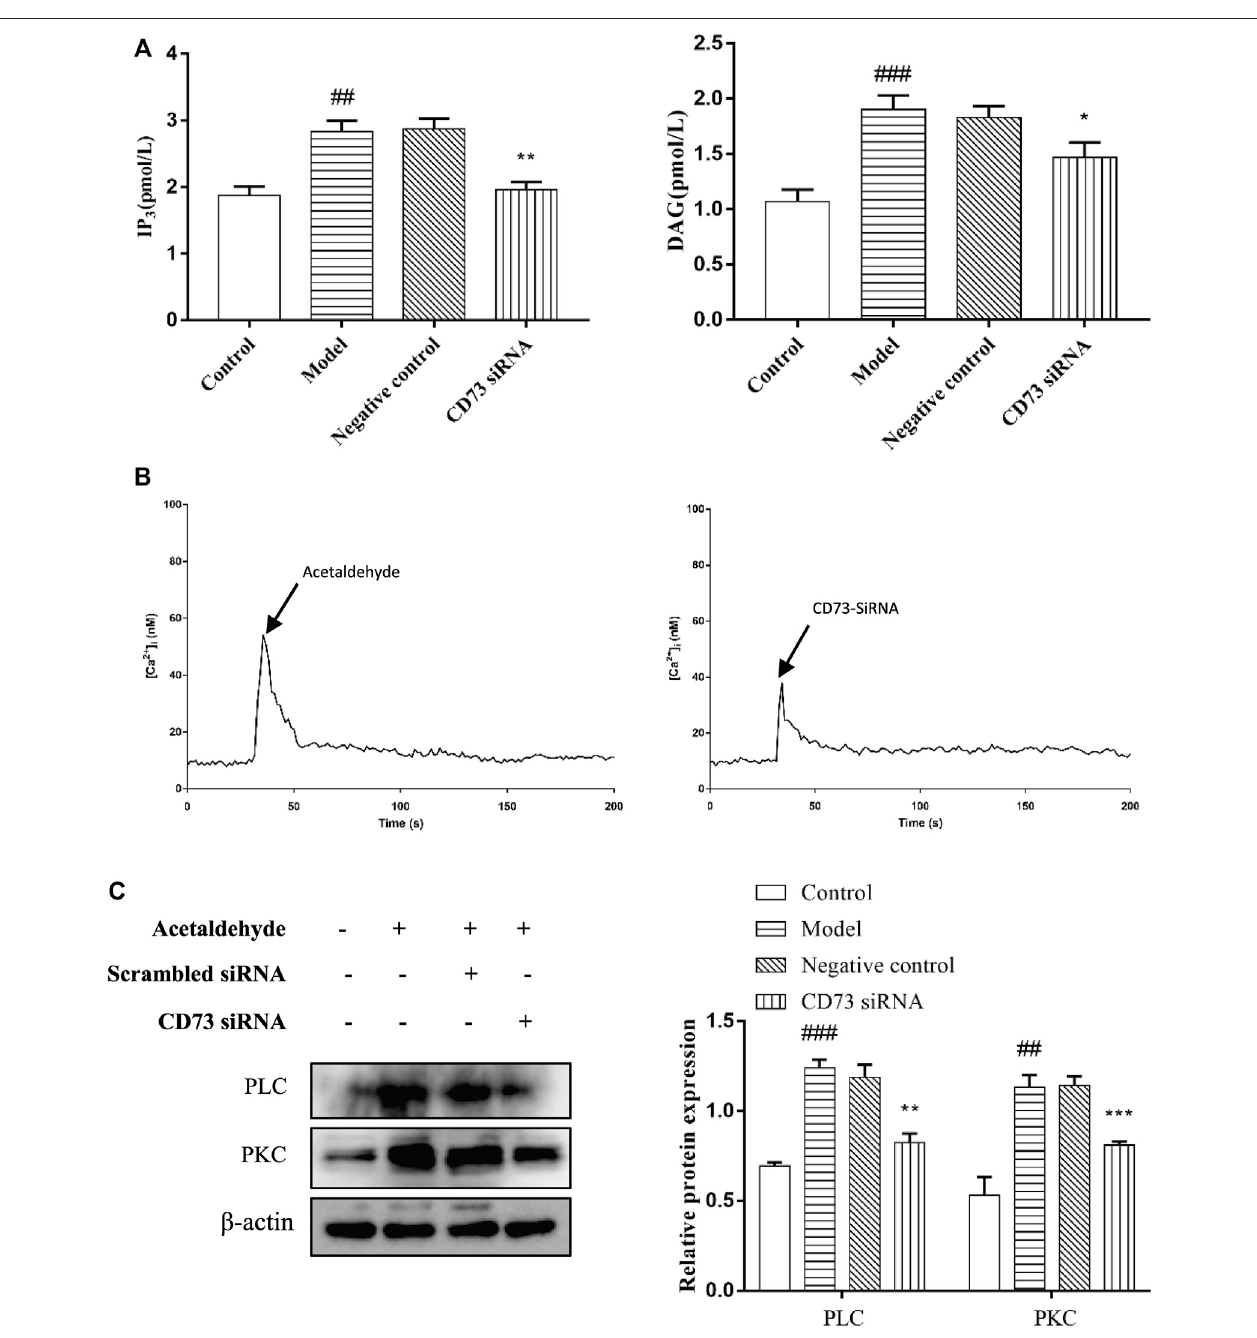
FIGURE 8 | CD73 positively regulates PLC- IP 3 -Ca 2+ /DAG-PKC signaling pathway activity in acetaldehyde -induced HSC-T6 cell. (A) The content of IP 3 and DAG were assessed by ELISA. (B) [Ca 2+ ] i concentration changes as visualized by Fluo-3-AM. (C) The protein levels of PLC and PKC in HSC-T6 cell. ## p < 0.01, ### p < 0.001 vs. the control group, *p < 0.05, **p < 0.01, ***p < 0.001 vs. the negative control group.